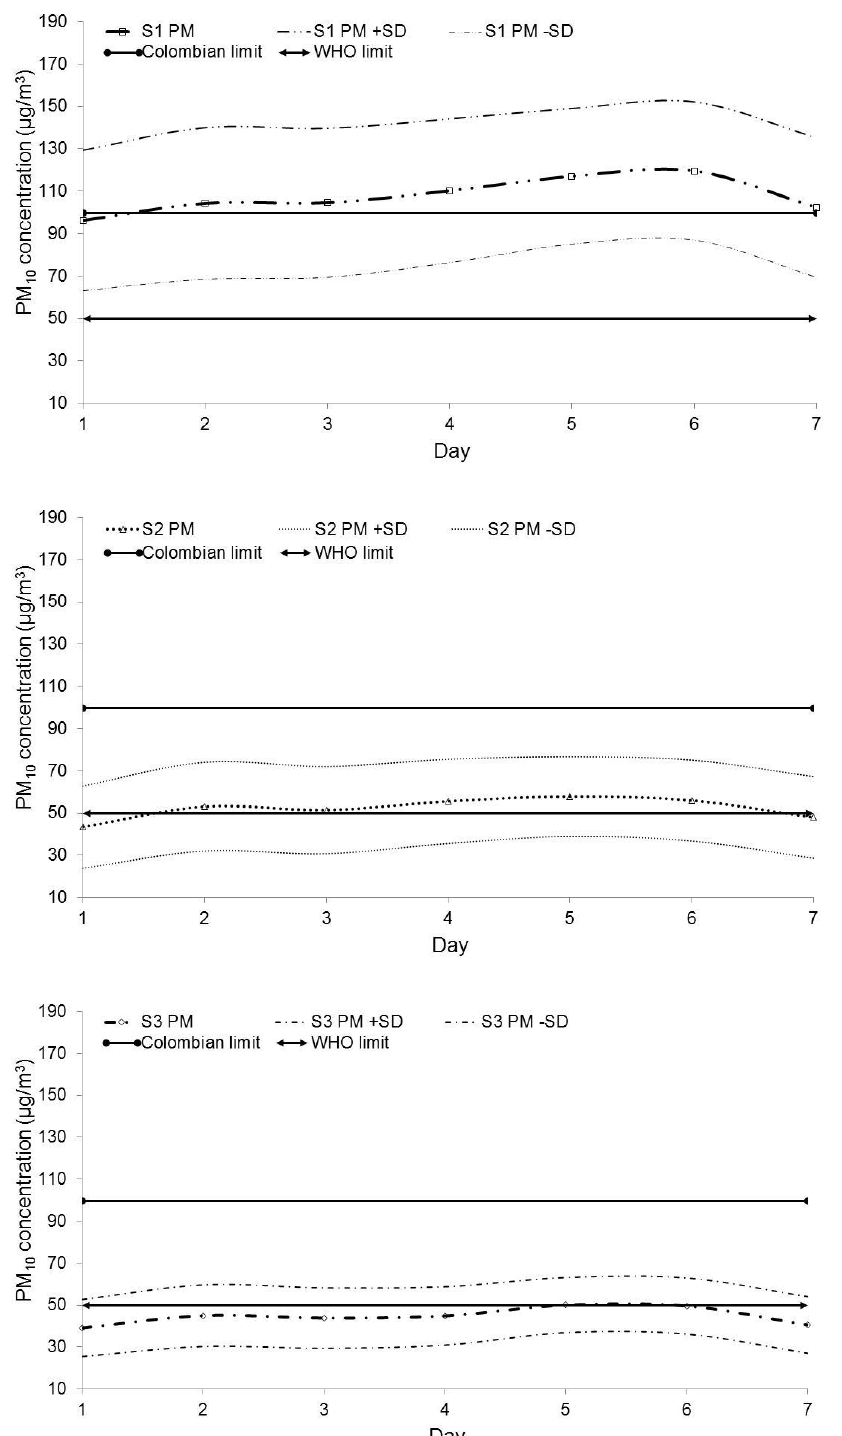
Figure 4. Average DPM 10 during February in monitoring stations (S1, S2, and S3). Day: 1 = Monday, 2 = Tuesday, 3 = Wednesday, 4 = Thursday, 5 = Friday, 6 = Saturday, and 7 = Sunday. PM = PM 10 concentration. SD = standard deviation.